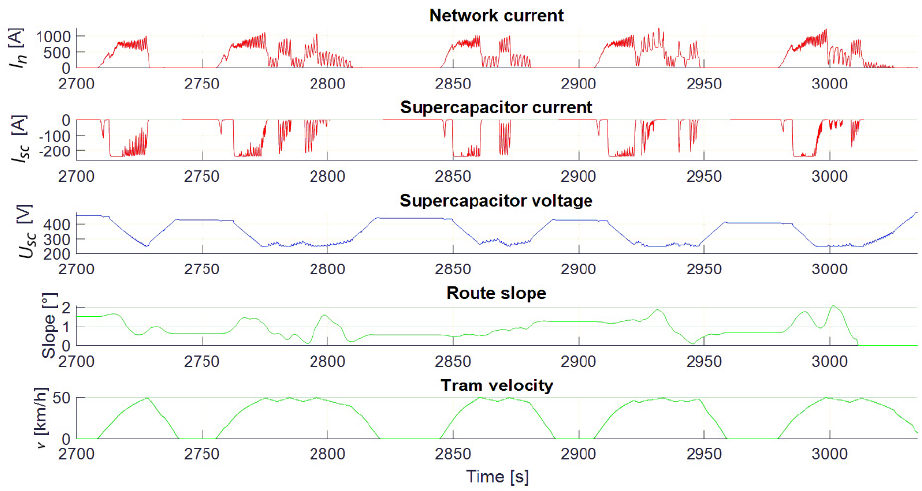
Figure 21. Enlarged view of the critical track section.